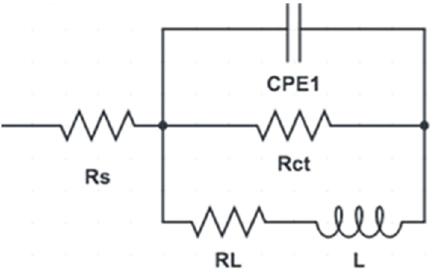
Figure 11. Equivalent circuit used to fit (EIS) data .